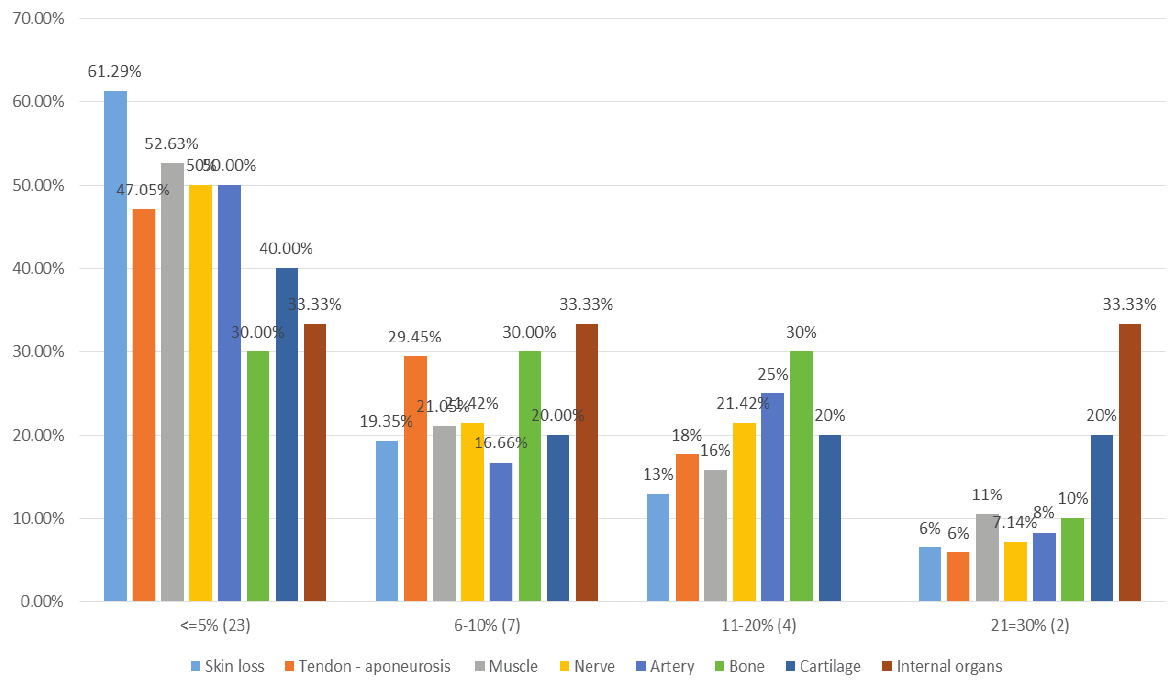
Figure 1: Differential deep structure injury vs total number of patients